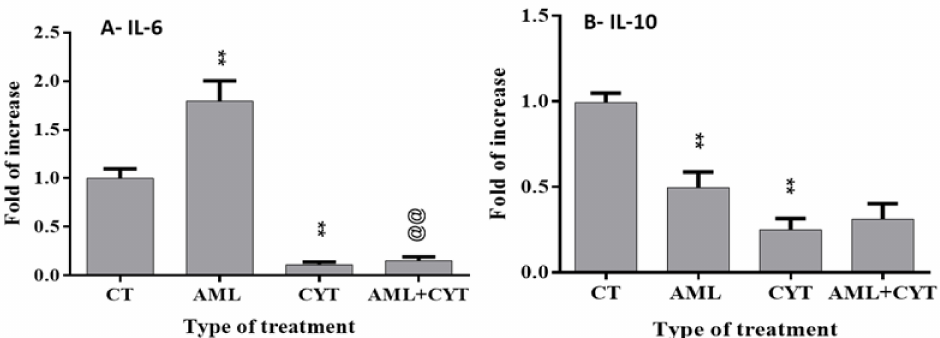
Figure 8. Effect of AML and CYT on the levels of testicular proinflammatory and anti-inflammatory cytokines of immature treated mice. Mice and testes were treated as described in Figure 1. Testes were removed after 2 weeks and used for RNA extraction. The RNA expression levels of IL-6 ( A ) and IL-10 ( B ) in the testes isolated from each treatment group were examined by qPCR analysis using specific primers, and housekeeping gene (GAPDH) was used as internal control. The results are presented as fold of increase compared to GAPDH. N = 4; n = 5–7/group (RNA expression). ** ( p < 0.01) significant relative to control group.@@ ( p < 0.01) significant relative to AML